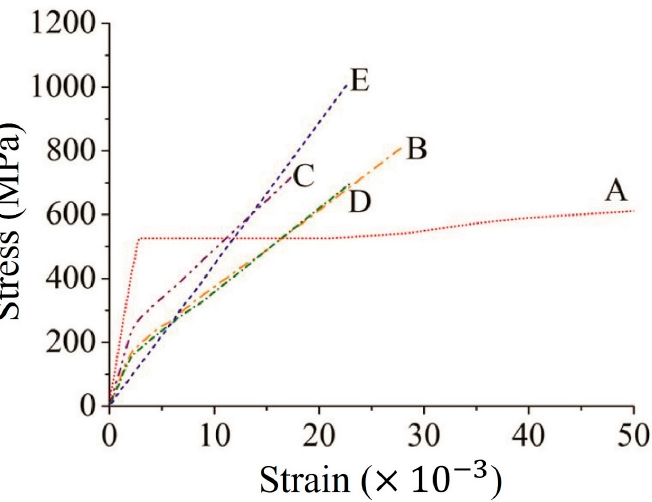
Figure 5. Tensile behaviour of steel compared to FRP (A) Steel, (B) Basalt FRP, (C) Basalt FRP, (D) Glass FRP, (E) Basalt FRP [89]. Reproduced with permission from Springer Nature 2023.